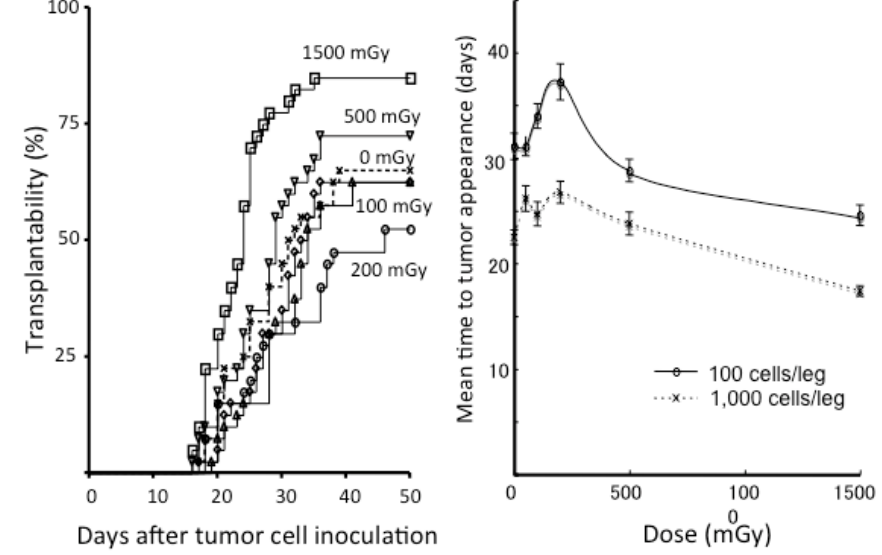
Figure 3. Left panel: Tumor transplantability curves for EMT6 tumors in Balb/c mice receiving 0 to 1500 mGy of whole-body irradiation given 6 h before inoculation of 100 EMT6 cells. Each group consisted of 40 inoculation sites. Right panel: Mean time to tumor appearance in Balb/c mice developing EMT6 tumors as a function of the whole-body dose. Bars represent SE. In the groups inoculated with 1000 EMT6 cells, the differences were significant between the sham-irradiated group and the groups receiving 100, 200, or 1500 mGy (all p < 0.005). In the groups inoculated with 100 EMT6 cells, significant differences were seen between the sham-irradiated group and the groups receiving 200 or 1500 mGy (both p < 0.01). Modified from Reference [51].